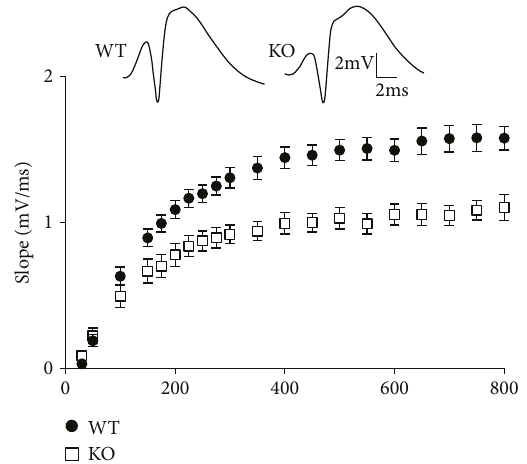
Figure 2: The lack of neuroligin-1 (NL1) leads to impaired synaptic transmission at excitatory perforant path synapses. This was shown by impaired stimulus-response relationship for the slope of the fi eld excitatory postsynaptic potential (fEPSP) in NL1 knockout (KO) mice. The fEPSP slope is a measure for the strength of synaptic transmission. Field potential responses were recorded in the hilus of the dentate gyrus. Slopes of fEPSPs were decreased in NL1 KO mice relative to their wild-type (WT) littermates. Top: representative recordings from one WT and one NL1 KO animal at 500 μ A stimulus strength (adapted with permission from